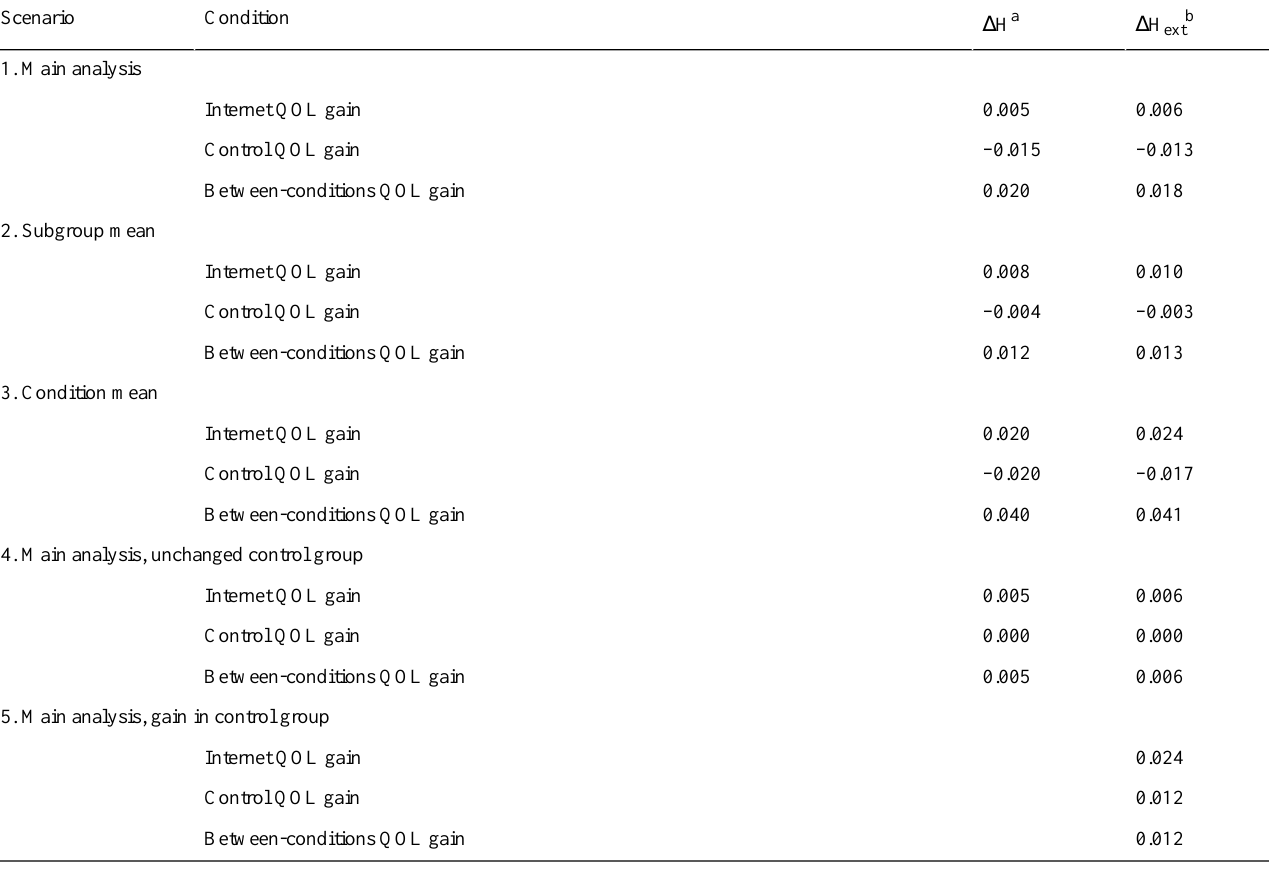
Table 8. Quality of life (QOL) sensitivity analysis within and between